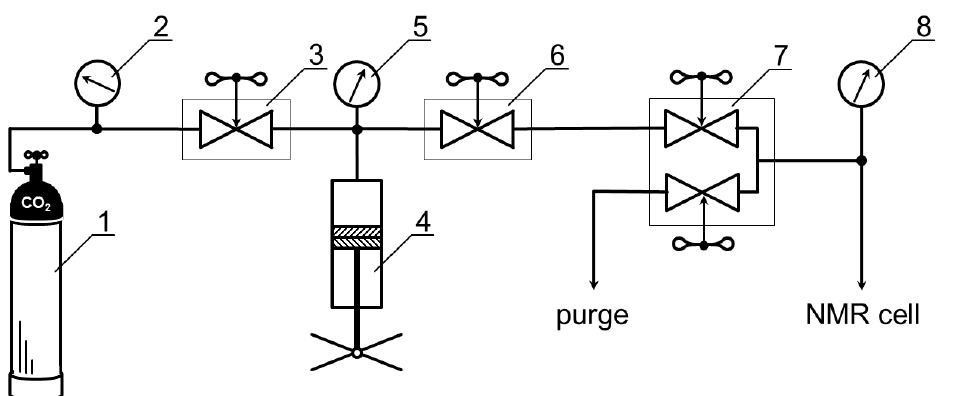
Figure 1. Scheme of the installation of high pressure equipment for creating and maintaining high pressure NMR experiments for the supercritical CO 2 . 1 — gas cylinde; 2,5,8 — pressure transmitters; 3,6 — high-pressure valves; 4 — hand press; 7 — hand valves.